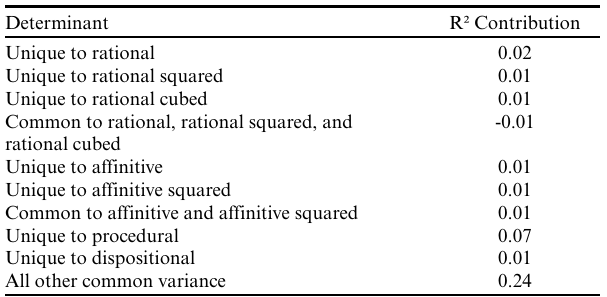
Table 3 . Commonality analysis showing the unique variance explained by the determinants of trust and